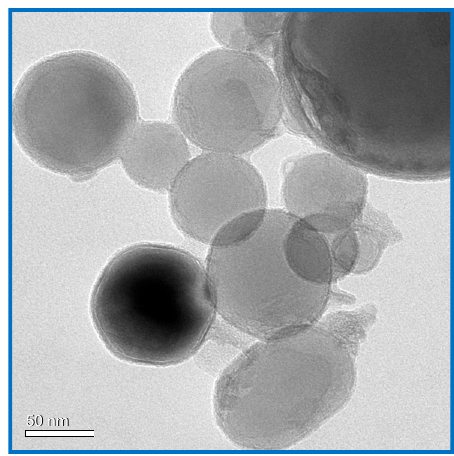
Figure 1. SEM picture of super fine RDX.